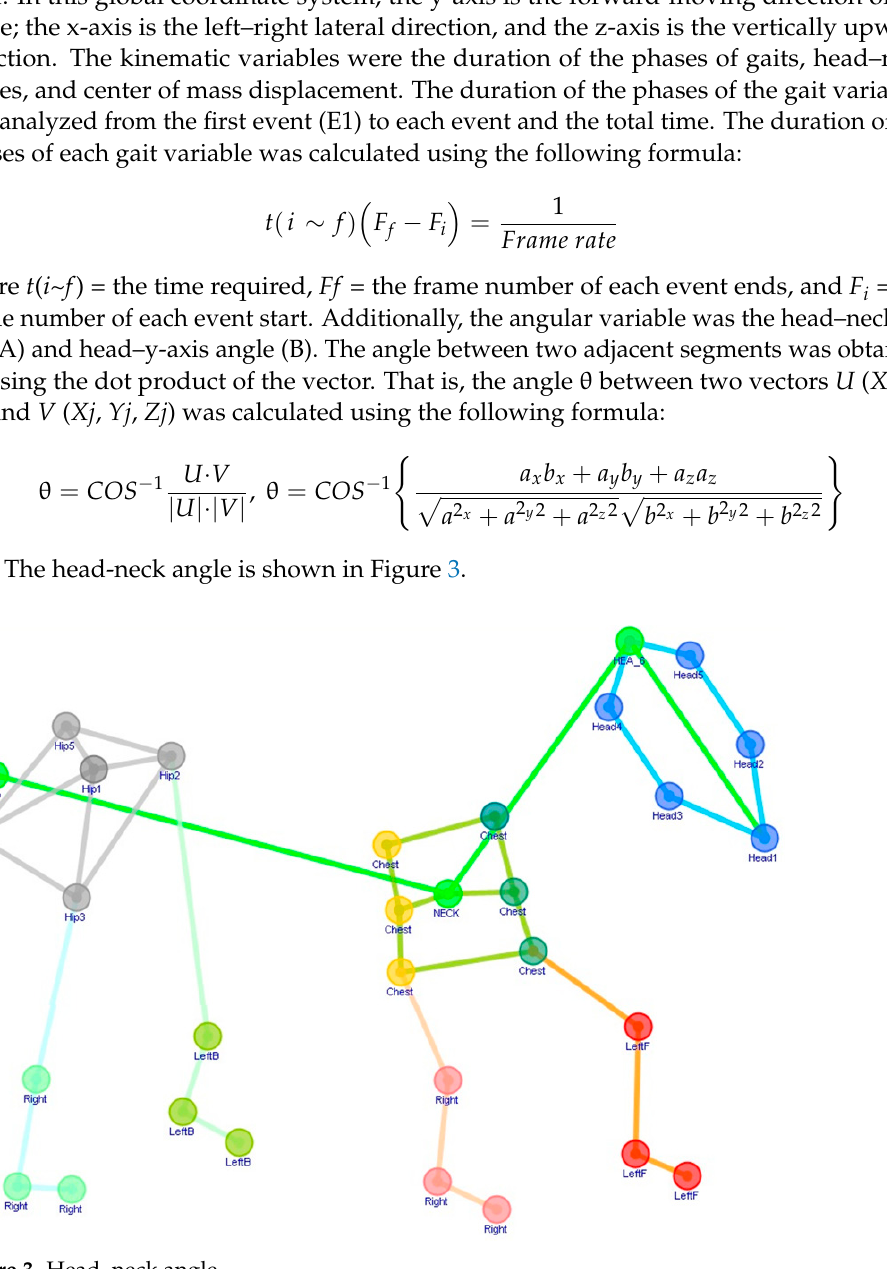
Figure 3. Head–neck angle.